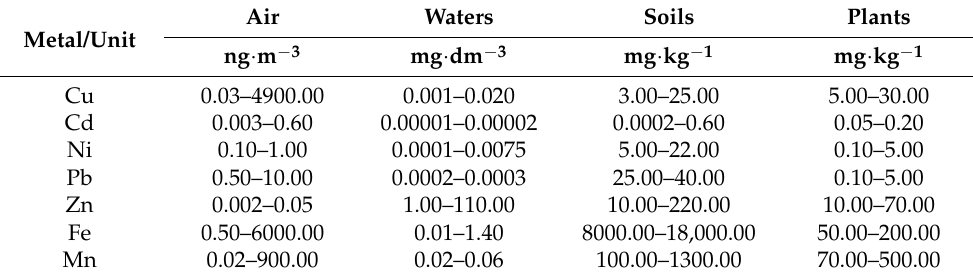
Table 1. Ranges of metal content in environmental components [11,12].